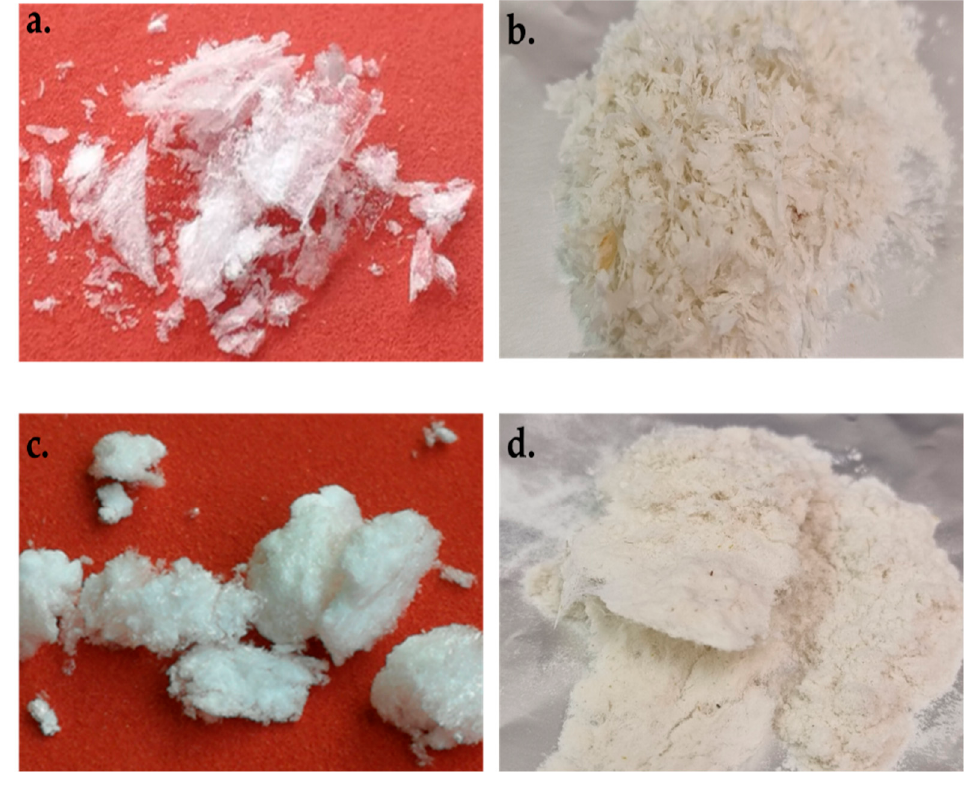
Figure 4. Result of keratin extraction: extracted keratin ( a ) and residue ( b ) from chicken feathers; extracted keratin ( c ) and residue ( d ) from sheep wool.